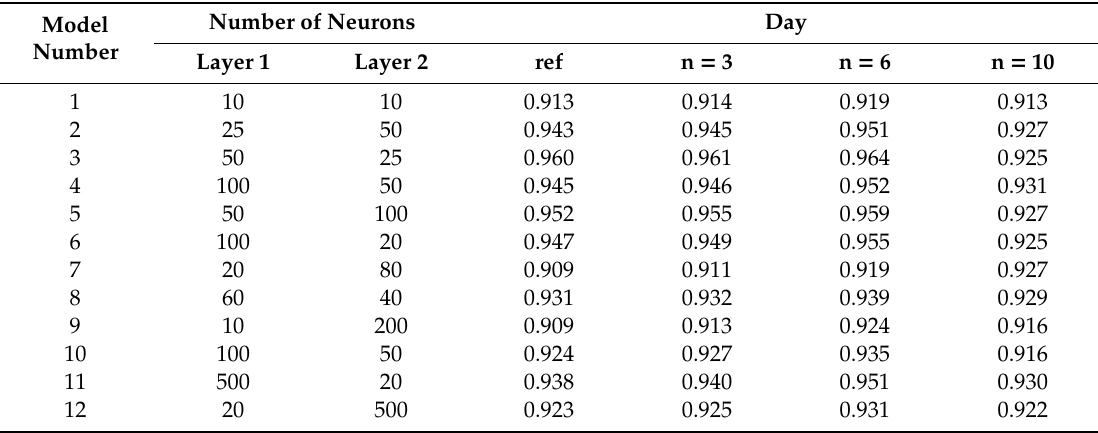
Table 6. Correlation analysis for the reference signals and wavelet-based filtration (day).